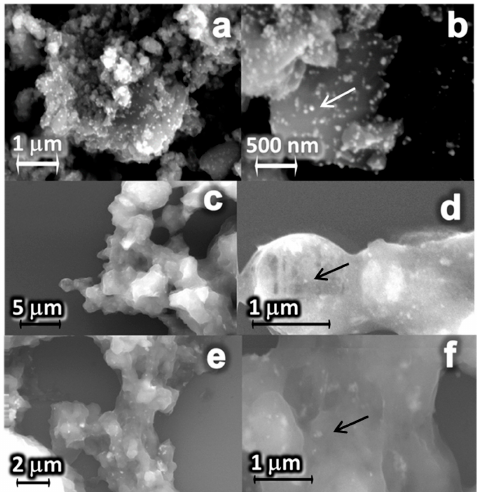
Figure 2. SEM images of the Ag-CaGP nanocomposites: B4 ( a , b ), C4 ( c , d ), and B8 ( e , f ) at different magnifications. The arrows indicate silver nanoparticles on the surface of CaGP in B4 and in the bulk of CaGP in C4 and B8.